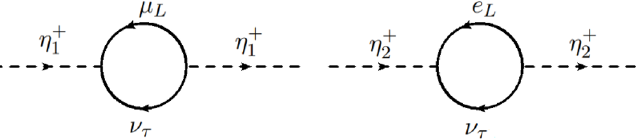
Figure 5 . Feynman diagrams generating mass splitting among doublet scalars of SU(2) H